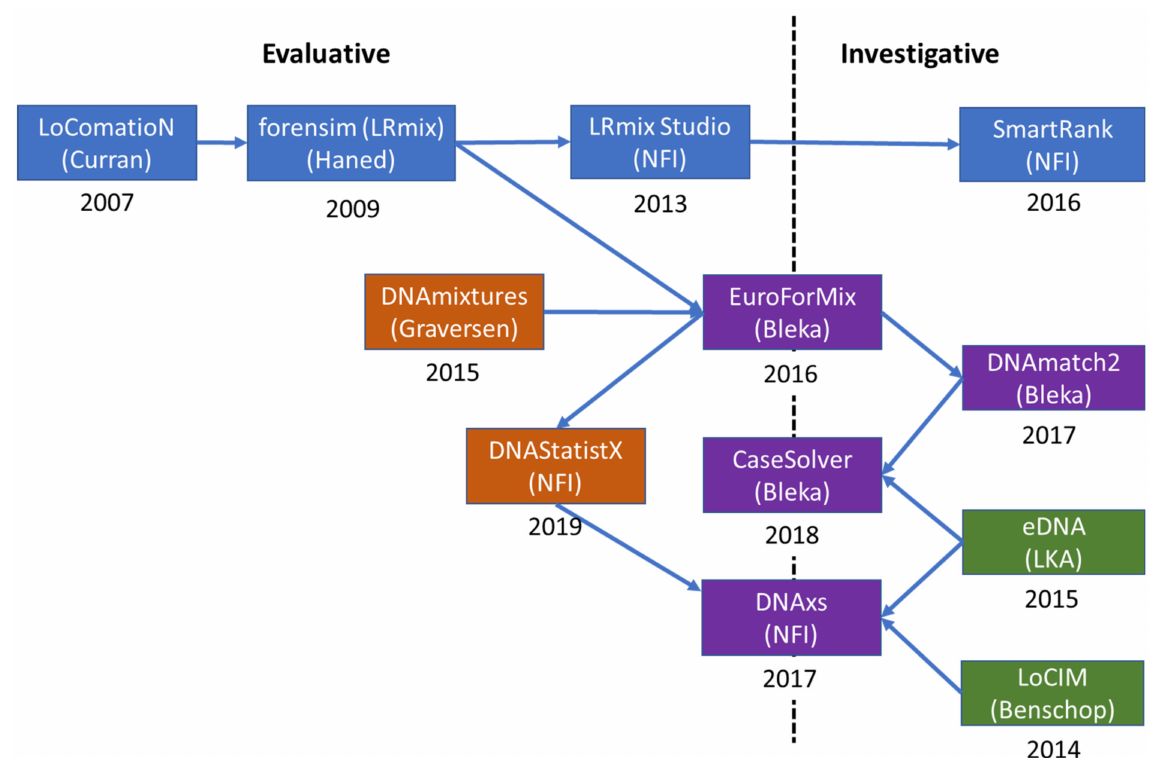
Figure 2. A diagram showing the evolution of probabilistic genotyping software developed by the NFI and Oslo University Hospital. Blue and orange boxes indicate qualitative and quantitative ( γ ) models, respectively. Green boxes are binary methods and purple boxes indicate software that include multiple types of